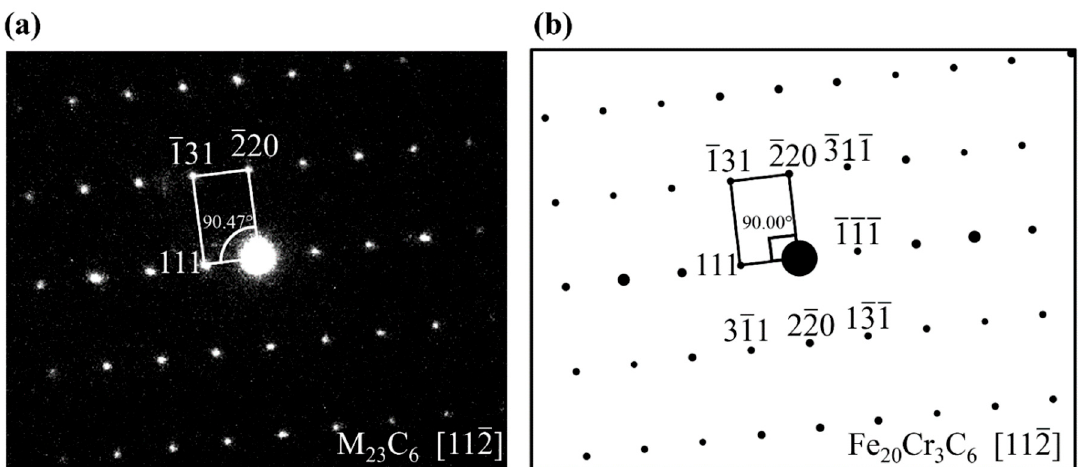
Figure 2. ( a ) Selected area electron diffraction (SAED) pattern of the experimental results [4]. Observation of carbon replicas tempered at 823 K for 1 h with a 12 T magnetic field. M 23 C 6 was identified by using its cubic unit cells; ( b ) simulated SAED pattern of Fe 20 Cr 3 C 6 along [112] zone axes. The intensity of the diffraction spot is proportional to its area.